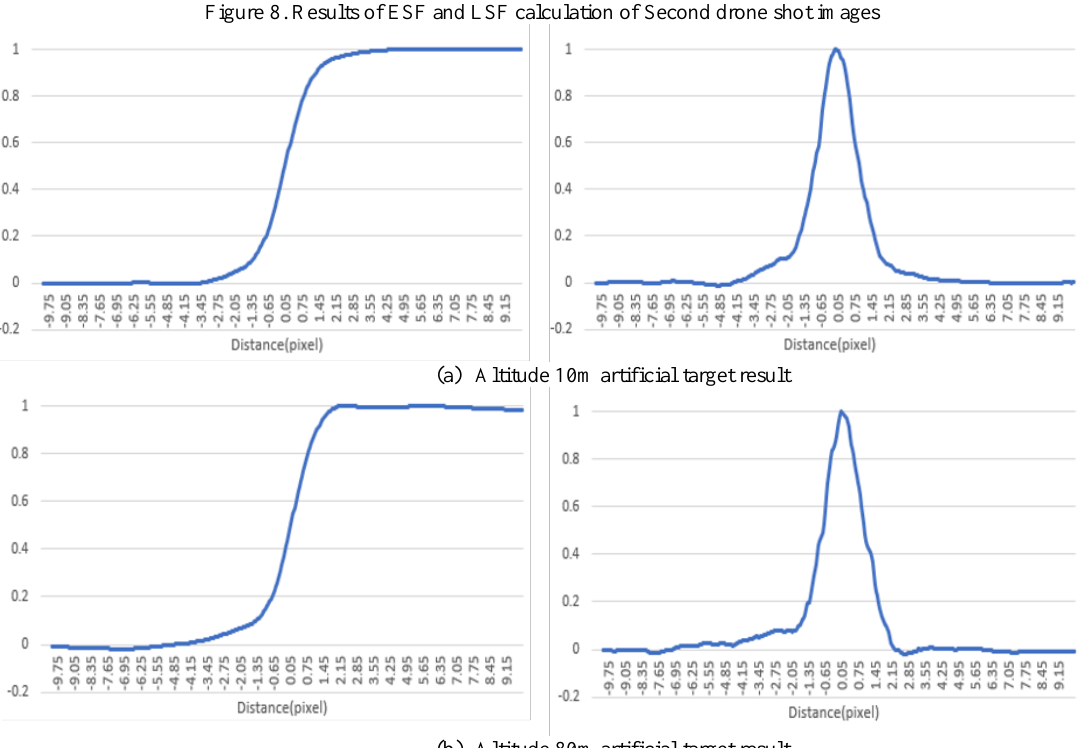
Figure 8. Results of ESF and LSF calculation of Second drone shot images